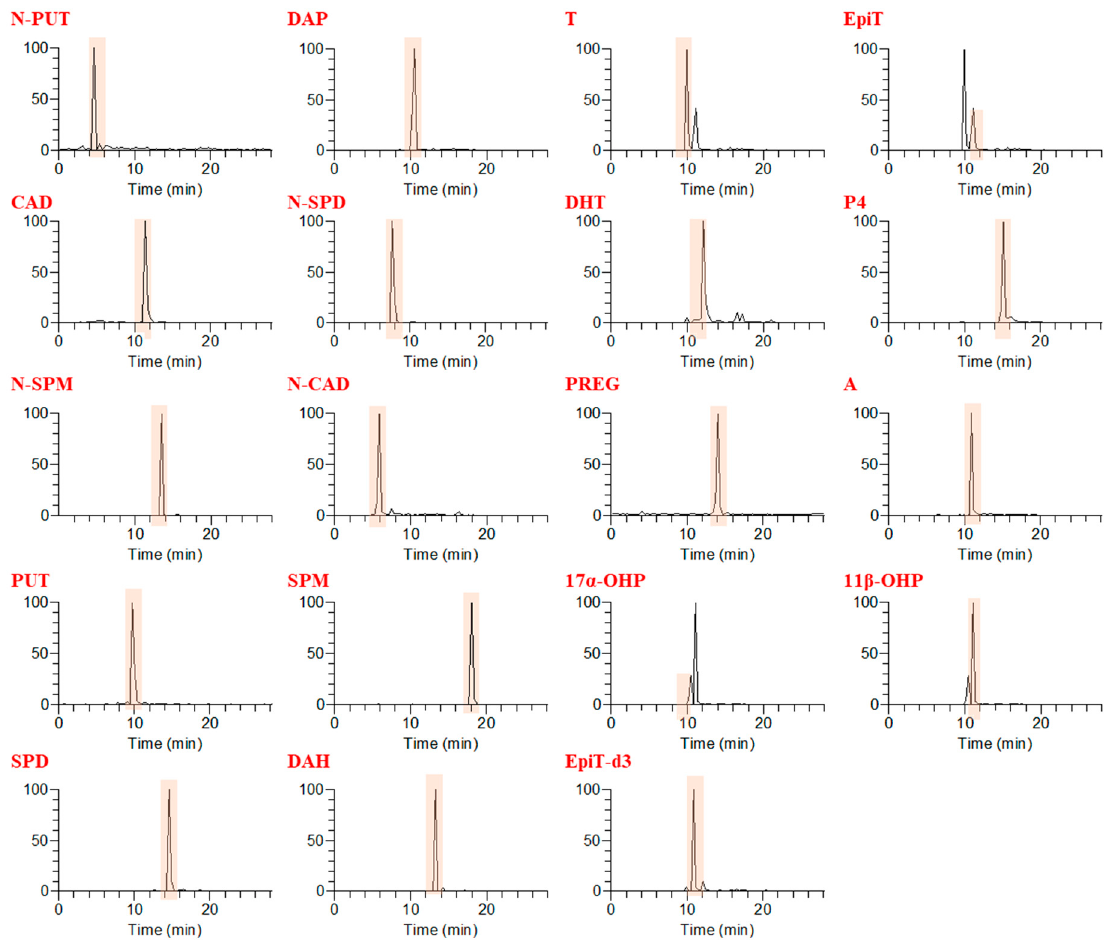
Figure 2. Chromatograms of nine polyamines, eight steroids, and two internal standards (IS) in the selected reaction monitoring mode, with target standard pretreatment (500 ng/mL). N-PUT: N -acetyl putrescine; CAD: cadaverine; N-SPM: N -acetyl spermine; PUT: putrescine; SPD: spermidine; DAP: 1,3-diaminopropane; N-SPD: N -acetyl spermidine; N-CAD: N -